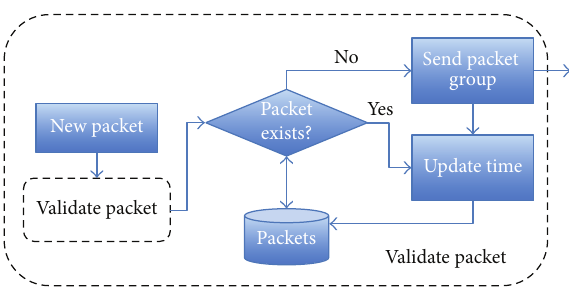
Figure 10: Leader flow when a packet is received.